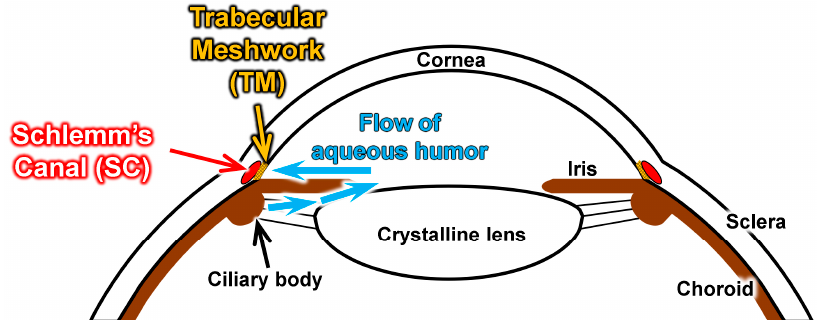
Figure 1. Schematic image of angle structure at corneal limbus and flow of aqueous humor in a human eye.